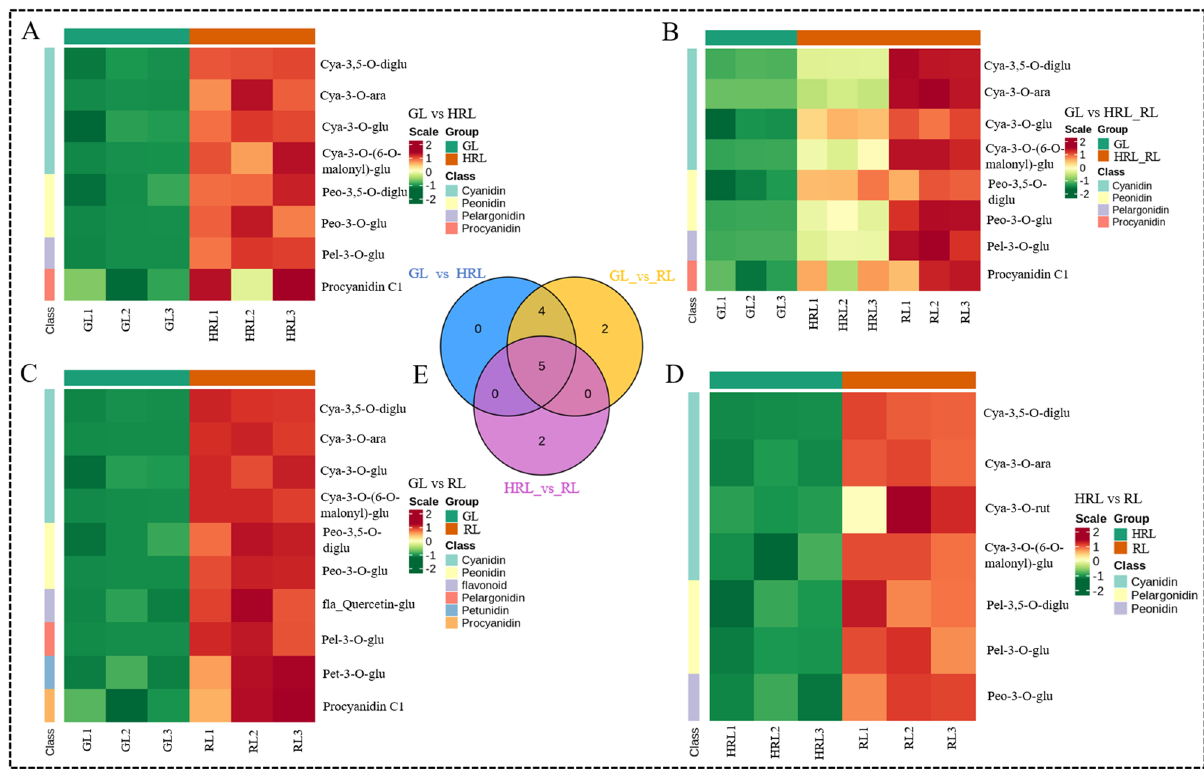
Figure 3. Metabolite expression level analysis of A. mandshuricum in different leaf sample groups. ( A – D ) DAMs in the anthocyanin biosynthesis pathway between four comparative groups of samples of A. mandshuricum . These DAMs were analyzed by KEGG enrichment analysis ( C , GL vs HRL; D , GL vs HRL_RL; E, GL vs RL; F, HRL vs RL). ( E ) Venn diagram of metabolites between three compared groups of leaf Ontology), KOG (euKaryotic Ortholog Groups), Pfam databases (protein family) and Trembl. A total of 201,642 unigenes were successfully annotated, of which 150,946 unigenes (74.86%) were annotated in at least one data- base above (Table S5 and Fig. S3). Among the 20,162 unigenes, 96,552 (47.88%) unigenes were grouped into 25 KOG classifications; the most highly represented was group R (general function prediction only), and group C (energy production and conversion), group J (translation, ribosomal structure and biogenesis), group O (post- translational modification, protein turnover, chaperones) and T (signal transduction mechanisms) also shared a high percentage of genes (Fig. S4). A total of 116,336 unigenes were categorized into three GO categories (biological process, cellular component and molecular function) and further divided into 60 major functional groups (Fig. S5). To reflect the expression level of transcripts, FPKM was used as an indicator to measure the level of gene expression. Principal component analysis (PCA) of the samples showed that the biological replica- tions of GL samples and RL samples were obviously clustered together and significantly separated from each other, but the three HRL samples were dispersed (Fig. S6). Similar to the metabolomic analysis, there was a sig- nificant separation of samples with different colors, indicating that changes in the accumulation of metabolites from green to red leaves were closely controlled by differences in gene expression. Differentially expressed genes between different colored leaves. DESeq2 27 was used to analyze the differential expression between different sample groups, and the results showed that a total of 6988 (3106 down-regulated and 3882 up-regulated), 18,597 (11,442 down-regulated and 7155 up-regulated), and 11,474 (9433 down-regulated and 2041 up-regulated) DEGs were obtained in the GL vs HRL, GL vs RL, and HRL vs RL groups, respectively (Table S6). The differentially expressed genes (DEGs) were identified, and the results are shown in Fig. 4. From the Venn diagram, 217 genes were the common DEGs in all comparison groups, suggest- ing that those genes across the three comparison groups might be associated with the leaf color change of A. mandshuricum (Fig. 4D). Next, we performed GO and KEGG functional annotation and pathway analysis in the three groups and found that the top enriched KEGG terms in the GL vs HRL group were ko01100 (metabolic pathways), ko01110 (biosynthesis of secondary metabolites), ko03010 (ribosome), ko04626 (plant-pathogen interaction) and ko04075 (plant hormone signal transduction) (Fig. S7). Among them, the metabolic pathways and biosynthesis of secondary metabolites were also abundant in the GL vs RL and HRL vs RL groups, indicat- ing that these DEGs might play a key role in leaf color change pathways (Table S7). GO functional enrichment analysis of DEGs between GL vs RL and GL vs HRL revealed that flavonoid metabolic process (GO: 0009812) and flavonoid biosynthetic process (GO:0009813) were significantly enriched (Fig. S8).